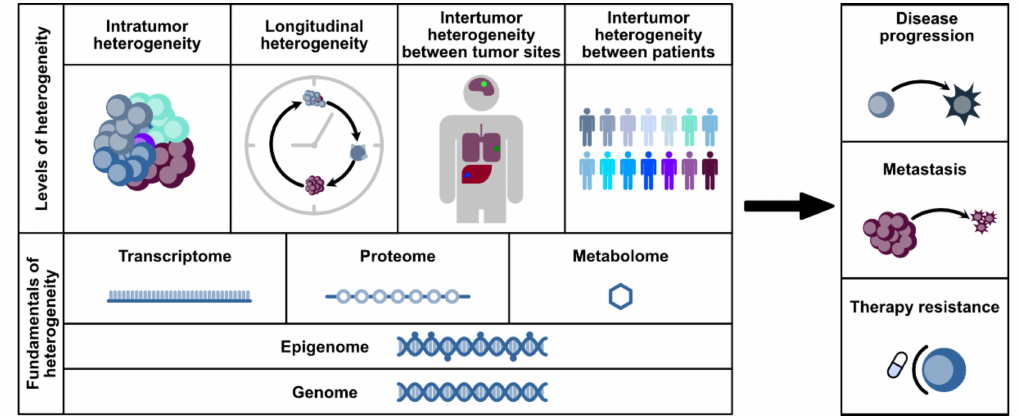
Figure 1. Levels of heterogeneity. Heterogeneity in tumors relies on different mechanisms within the genome, epigenome, transcriptome, proteome, or metabolome. Based on that, there can be distinct levels of heterogeneity: intra-tumor, longitudi- nal, and inter-tumor heterogeneity between tumor sites and between patients. Studying heterogeneity is imperative due to its crucial role in disease progression, metastasis, and therapy